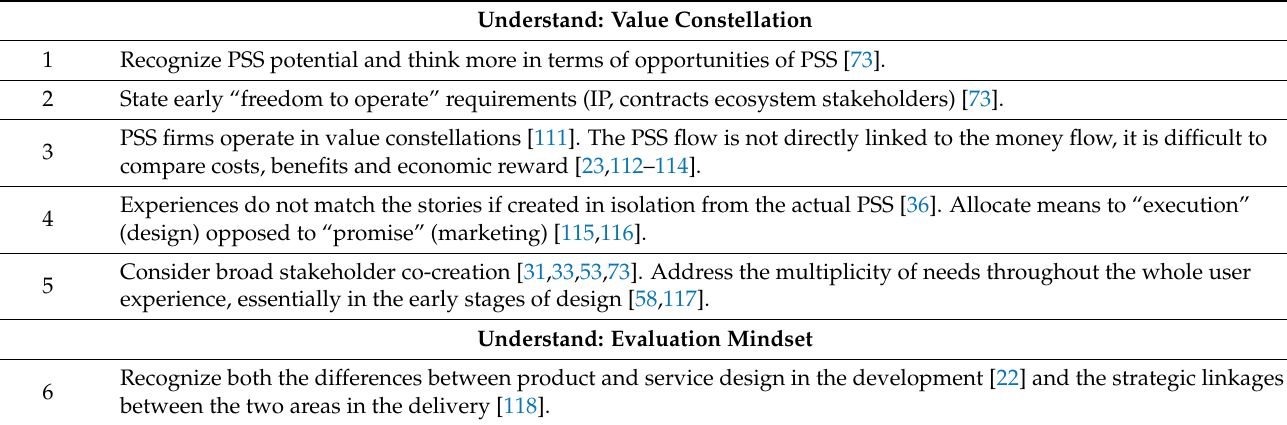
Table 3. PSS design process preconditions, structured by phase and